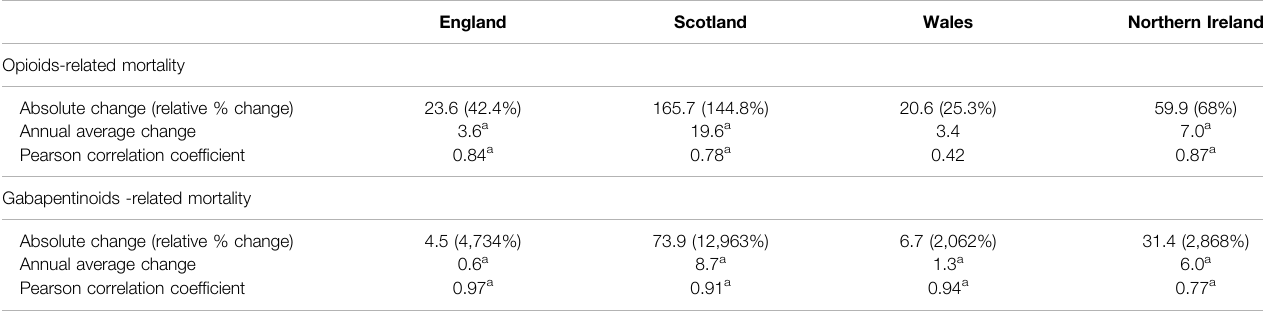
TABLE 3 | Absolute, relative, and average annual changes in the trends of opioids and gabapentinoids-related mortality and its association with their utilisation patterns across England, Scotland, Wales and Northern Ireland over the study period from 2010 to 2018. England Scotland Wales Northern